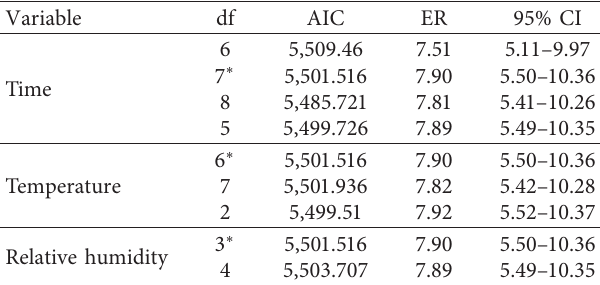
Figure 3: Excess risk (ER) and 95% confidence interval (CI) in daily hypertension hospital admission changes in the concentration of gaseous pollutants at different lag days: (a) excess risk (ER) in daily hypertension hospital admissions per 10 μ g/m 3 increase in SO 2 , in single- day lag 56–64days; (b) excess risk (ER) in daily hypertension hospital admissions per 10 μ g/m 3 increase in NO 2 , in single-day lag 56–64days; (c) excess risk (ER) in daily hypertension hospital admissions per 10 μ g/m 3 increase in O 3 , in single-day lag 56–64days; and (d) excess risk (ER) in daily hypertension hospital admissions per 10mg/m 3 increase in CO, in single-day lag 56–64 days. Table 4: Changes in PM 2.5 concentration on lag day 60 and changes in 95% CIs excess risk (ER) of hypertension hospital admissions with different df values of time, temperature, and relative